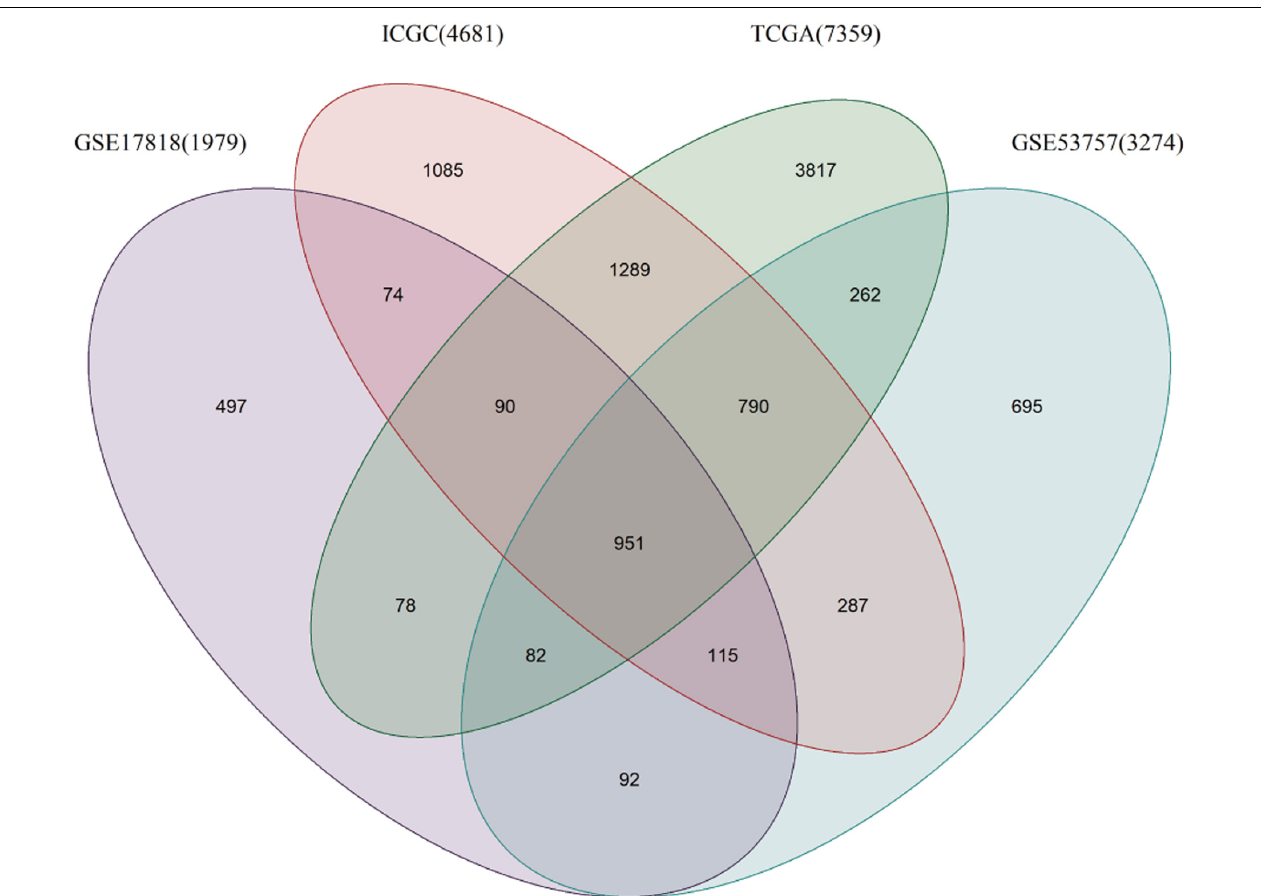
FIGURE 1 | Venn diagram of genes differentially expressed between ccRCC and normal